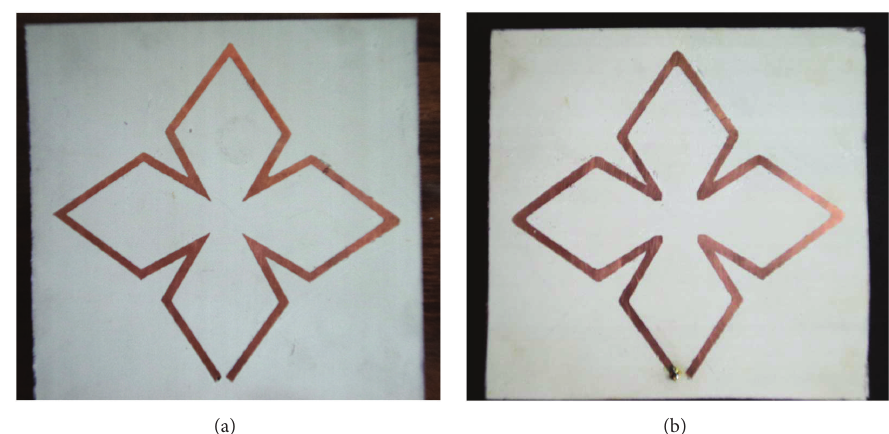
Figure 15: Constructed antennas (a) sharp edges and (b) soft edges.